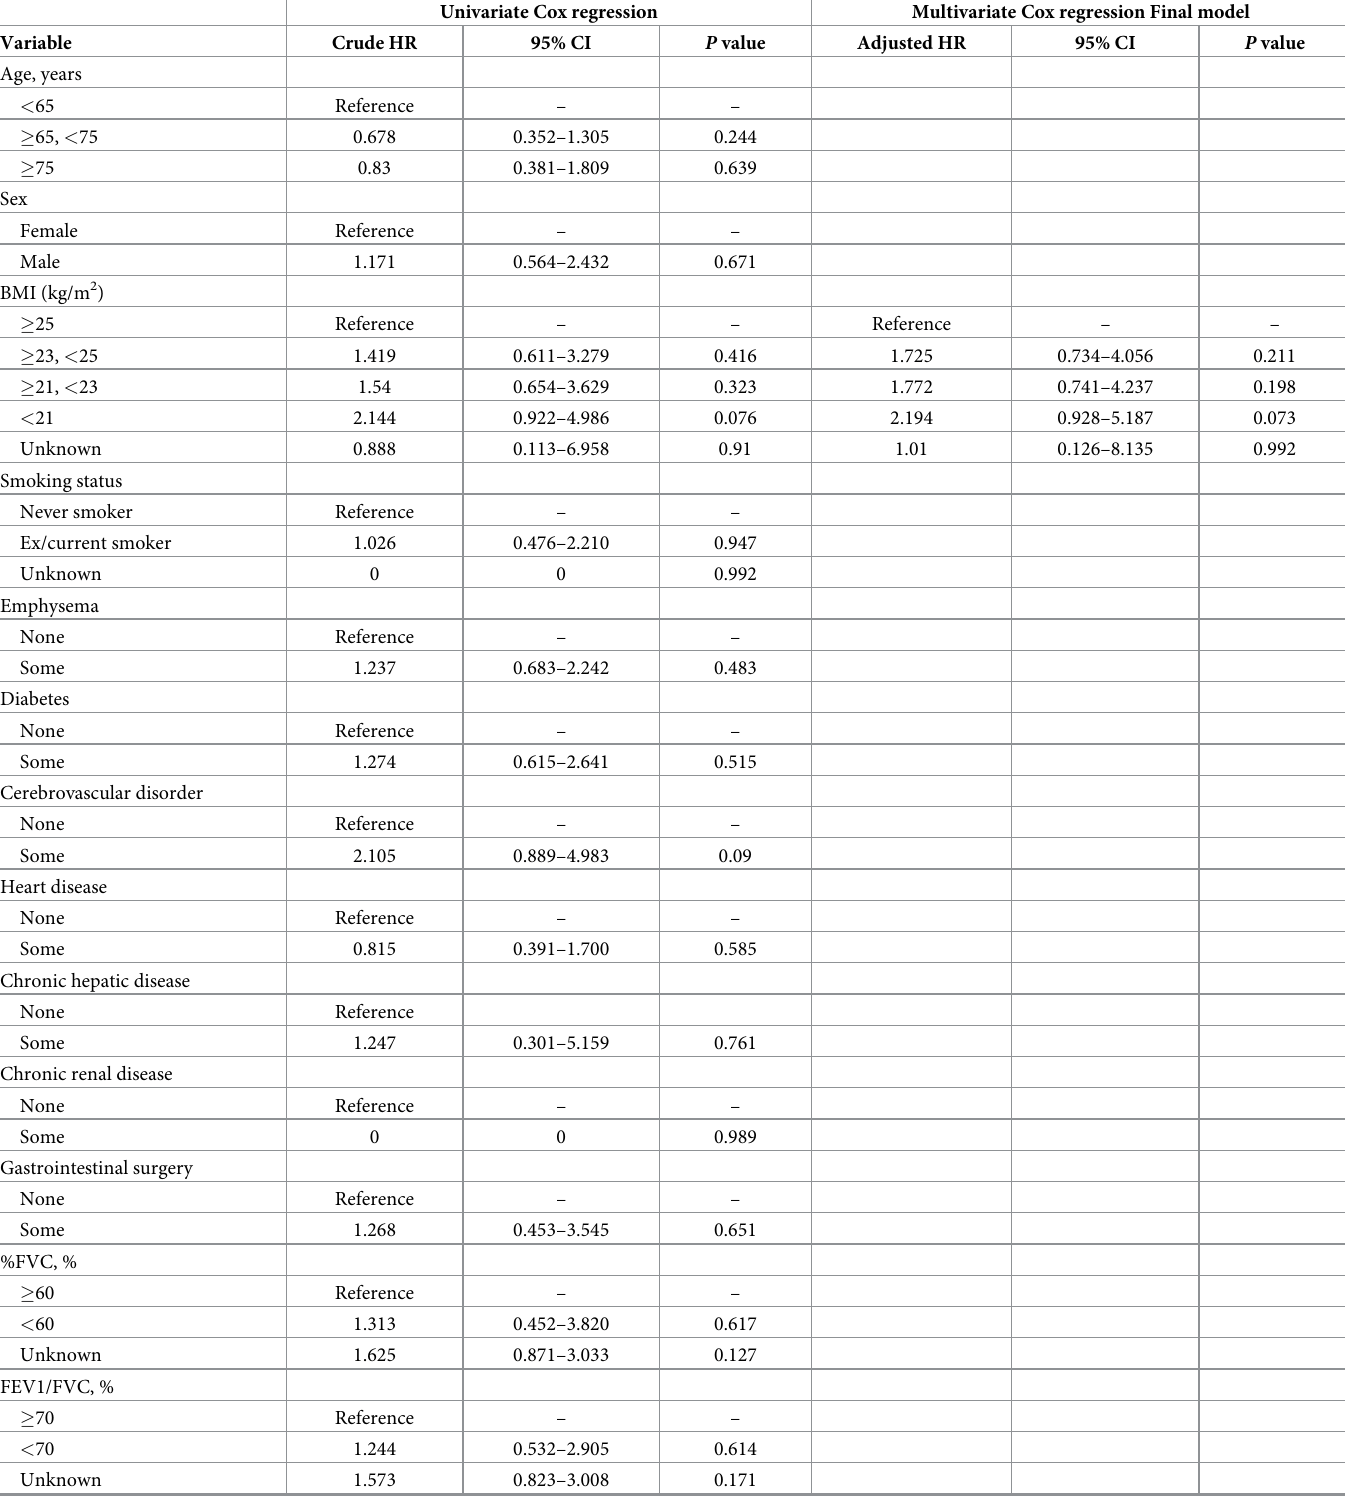
Table 3. Univariate and multivariate analysis of the risk of chronic pulmonary infections (Groups A,